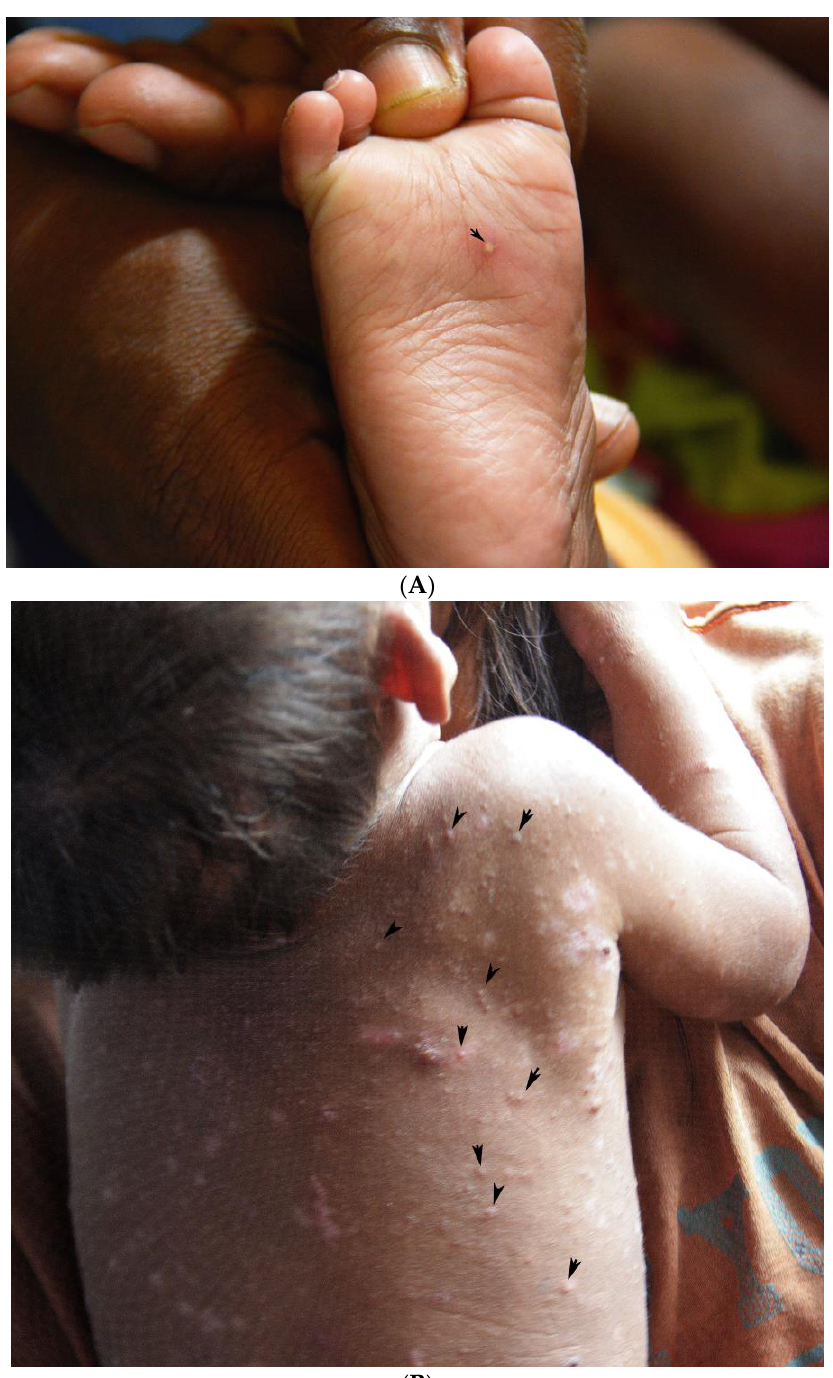
Figure 2. ( A ) A pearly vesicle at the sole of the foot (arrow). ( B) . Multiple pearly vesicles on the back of a child with severe scabies (arrows).